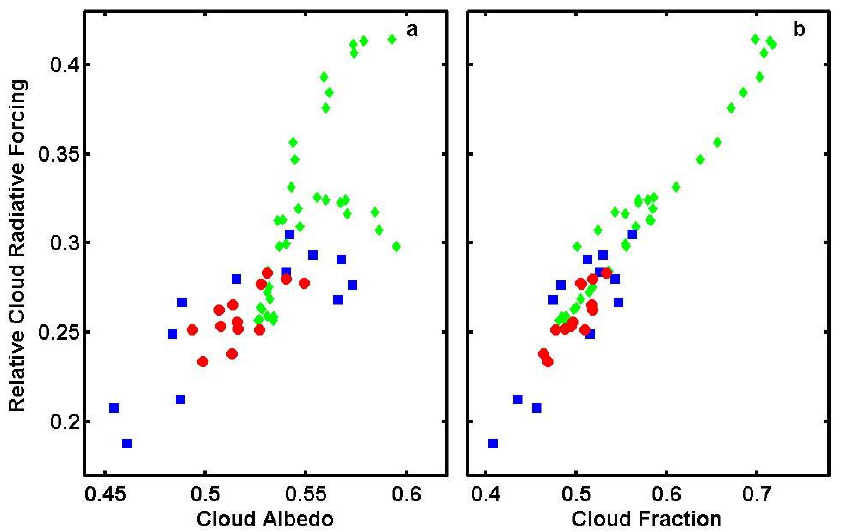
Fig. 12. Scatter plots showing correlation between the relative surface shortwave cloud radiative forcing and cloud fraction (a) , and cloud albedo (b) . The colors of red, green and blue denote hourly, monthly, and annual averages,